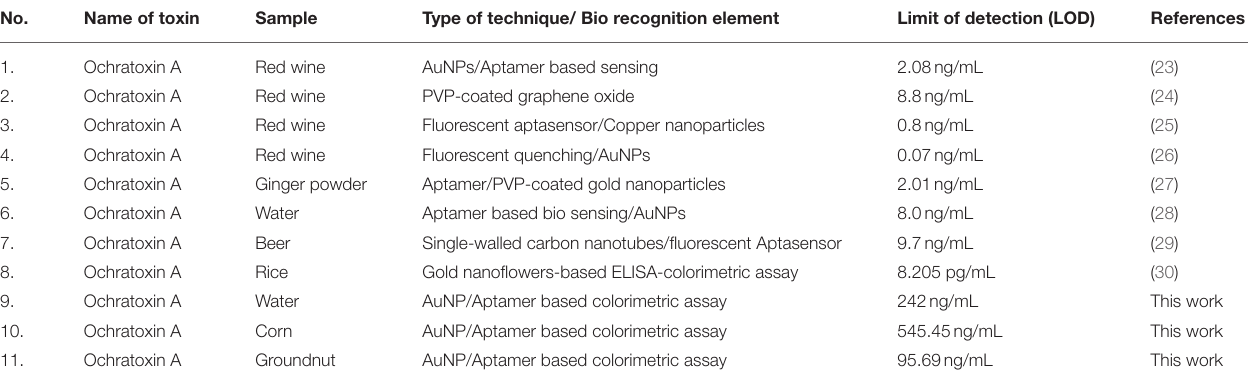
TABLE 1 | Comparison between the colorimetric and fluorescence-based assay for the detection of OTA in food samples and water. No.